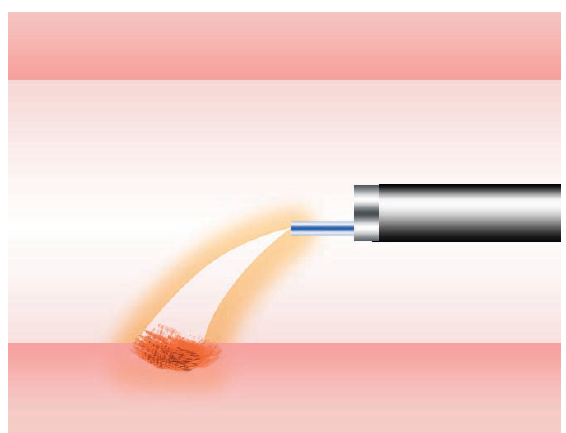
Figure 6. Probe with high frequency electricity being passed through the jet of